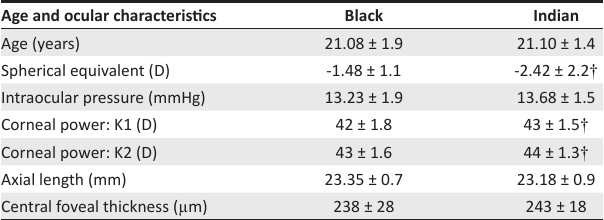
TABLE 1: Means and standard deviations for age and ocular characteristics of the black ( n = 40) and Indian ( n = 40) myopic participants. Age and ocular